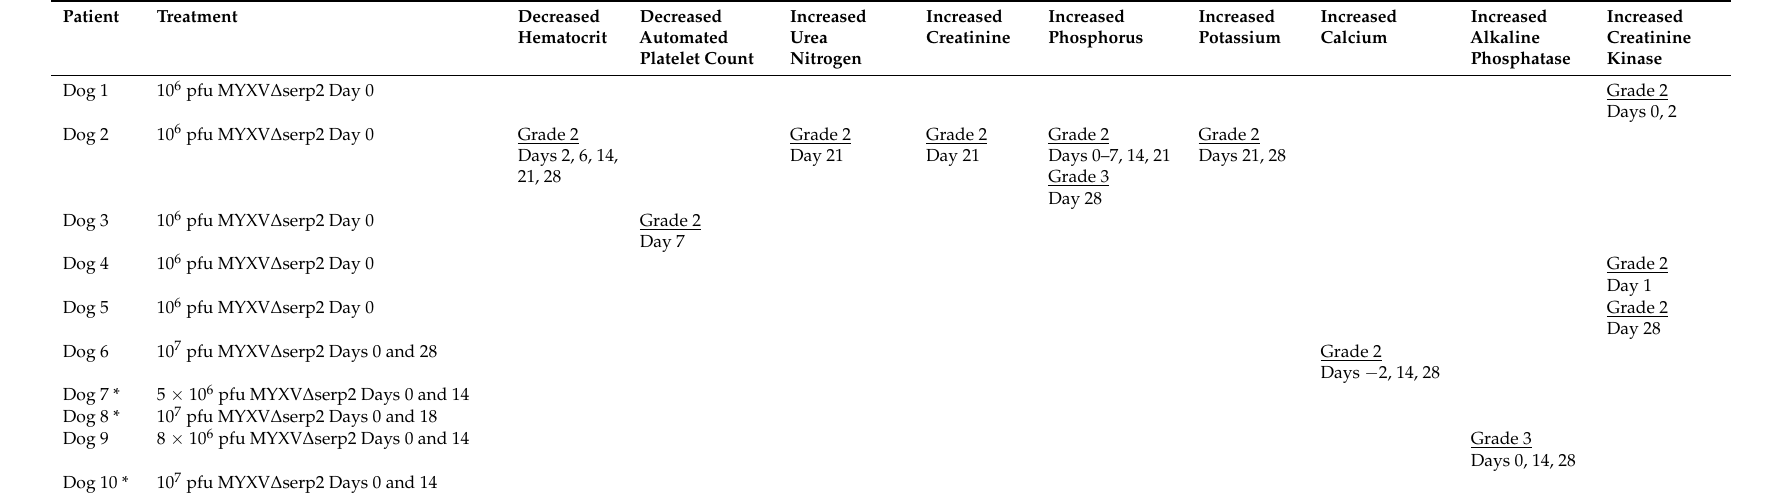
Table A1. Metabolic/laboratory adverse events graded ≥ 2 (using Veterinary Comparative Oncology Group criteria) that occurred in dogs treated with MYXV ∆